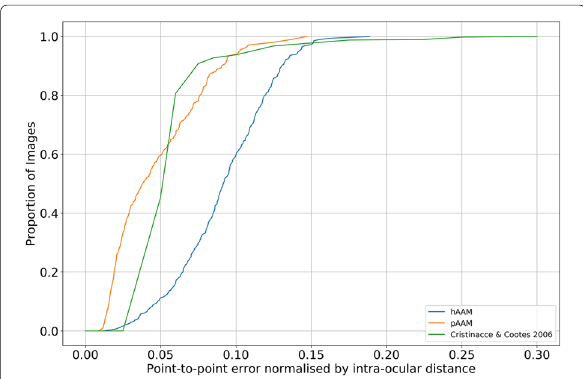
Fig. 13 300W (outdoor) cumulative error distributions. Comparing the performance of holistic AAMs, patch AAMs, and the performance reported by Yan et al. [48], Zhou et al. [58], and Milborrow et al.